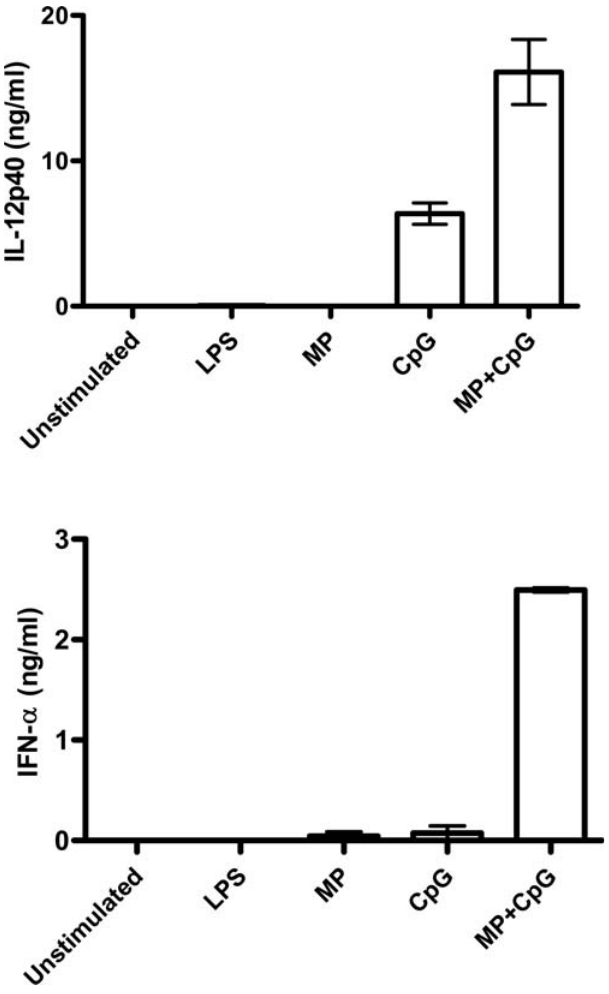
Figure 6. MP + CpG synergize to stimulate murine pDCs to produce IL-12p40 and IFN- a . pDCs were incubated with MP (1 m g/ ml), CpG ODN 2336 (1 m g/ml), or MP (1 m g/ml) + CpG (1 m g/ml). Supernatants were collected 40 hours later and analyzed by ELISA.